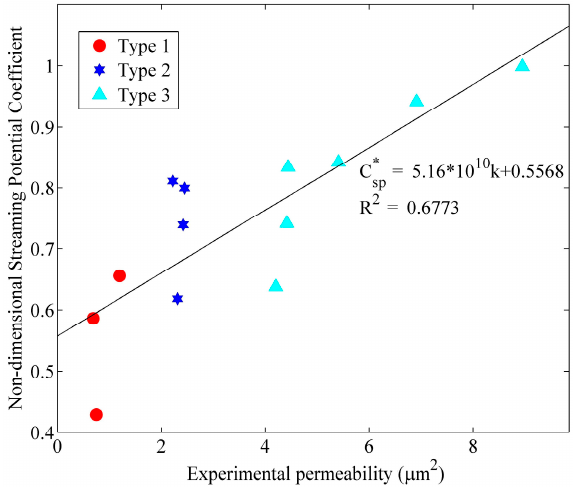
Figure 5. The relationship of streaming potential coupling coefficient versus experimental permeability.